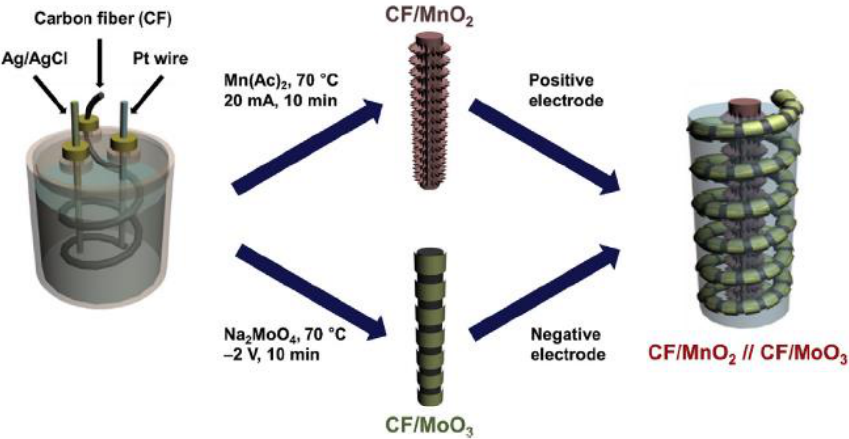
Figure 10. A schematic assembly of a fiber-shaped asymmetric supercapacitor (ASC) device based on CF/MnO 2 as the positive electrode and CF/MoO 3 as the negative electrode, respectively (reprinted with permission from Ref. [46]).